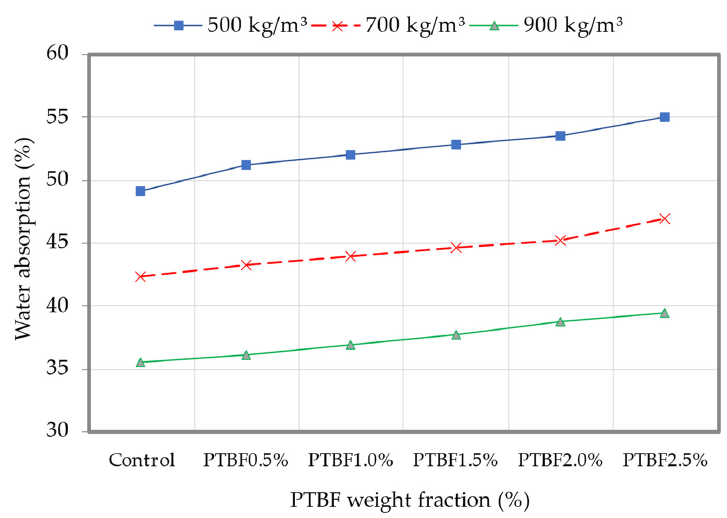
Figure 11. Water absorption of LFC with different weight fractions of PTBF.